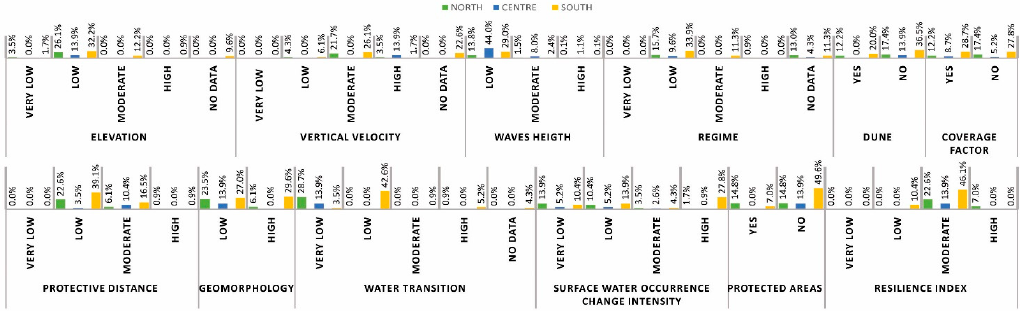
Figure 4. Discretized variables according to categorical (very low, low, moderate, high, no data) or Boolean (yes, no) values for each macro-sector: north (green), center (blue), and south (yellow).